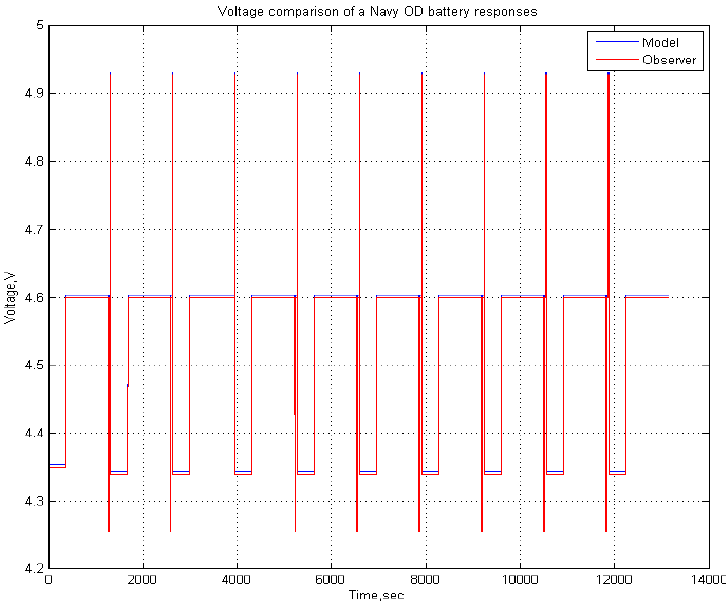
Figure 5. Model and observer response differences for Navy OD battery operation.